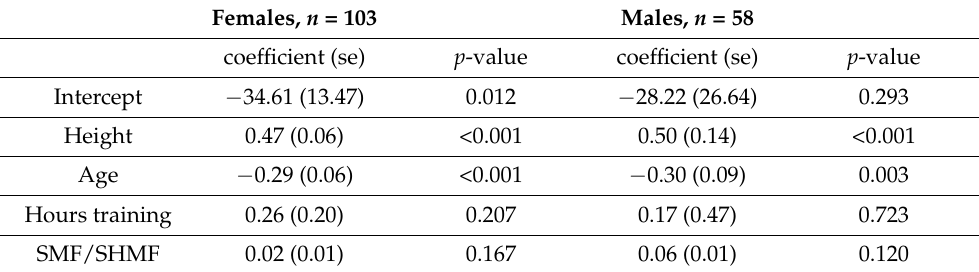
Table 2. Predictors of grip strength.